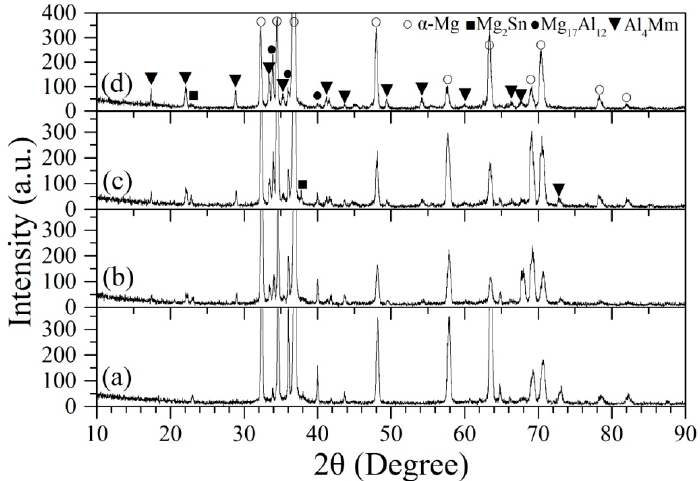
Figure 1. XRD patterns of as-cast samples for ( a ) ATZ731, ( b ) ATZE7310, ( c ) ATZE7311 and ( d ) ATZE7312 alloys.